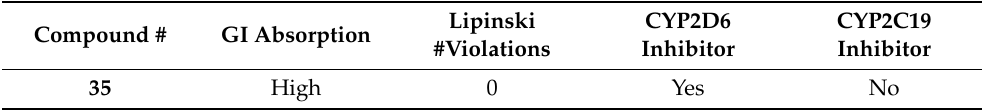
Table 4. Computed properties of compound 35 using